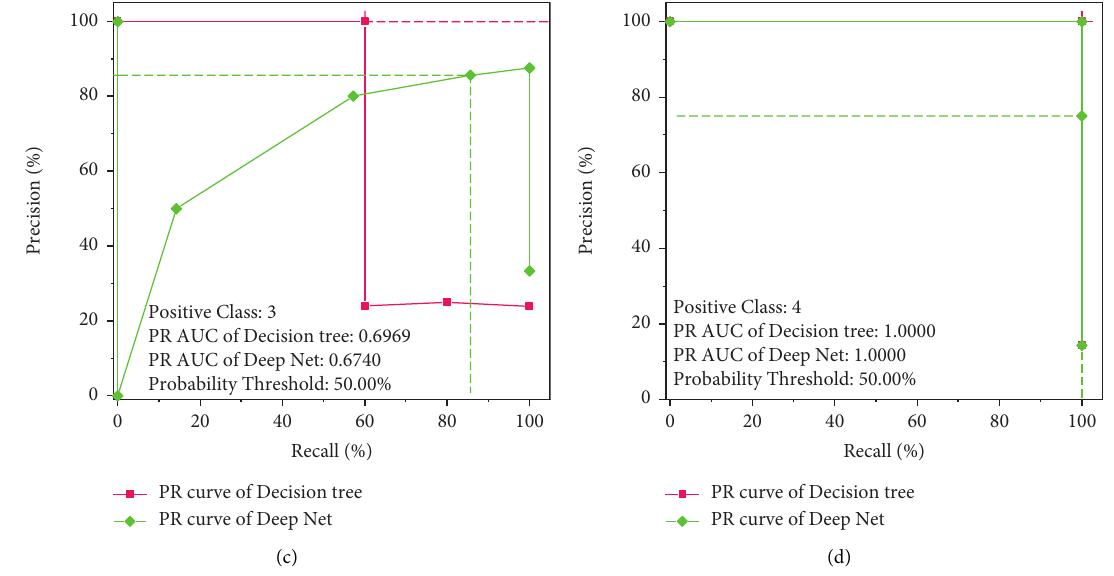
Figure 15: PR curve of each classification test of the deep network model.